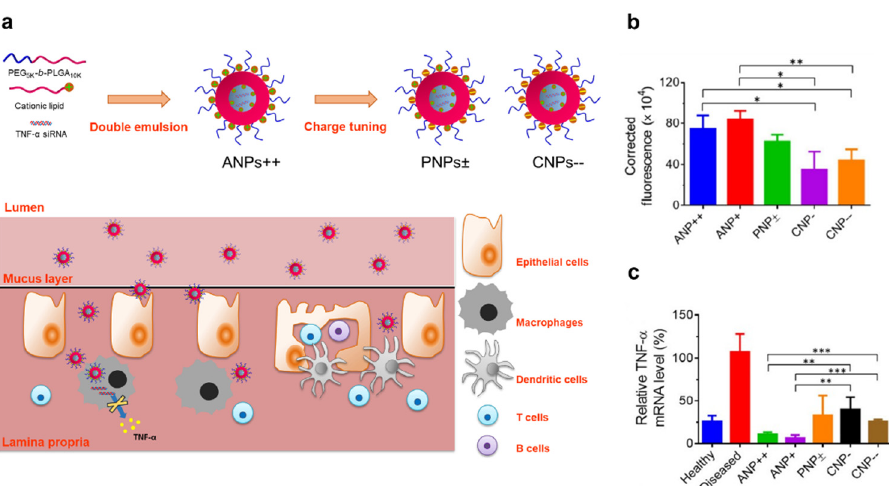
Figure 2. Oral siRNA nanotherapeutics based on polyplexes with a positive net charge show better targeting/therapeutic efficacy than those with a neutral/negative net charge. ( a ): Illustration of a methodology to modify the surface charge of siRNA-encapsulating polymeric NPs, highlighting the influence of surface charge on the oral delivery of siRNA for localized inflammatory disorders. ( b ): Aminated nanoparticles (ANPs) show a better targeting ability than plain NPs (PNPs) and carboxylated NPs (CNPs). ( c ): ANPs exhibited better therapeutic efficacy in a DSS-induced murine colitis model than PNPs and CNPs. Statistical p -values: * p < 0.05, ** p < 0.01, *** p < 0.001. Reprinted/adapted with permission from Ref. [89]. 2018, Springer Nature.